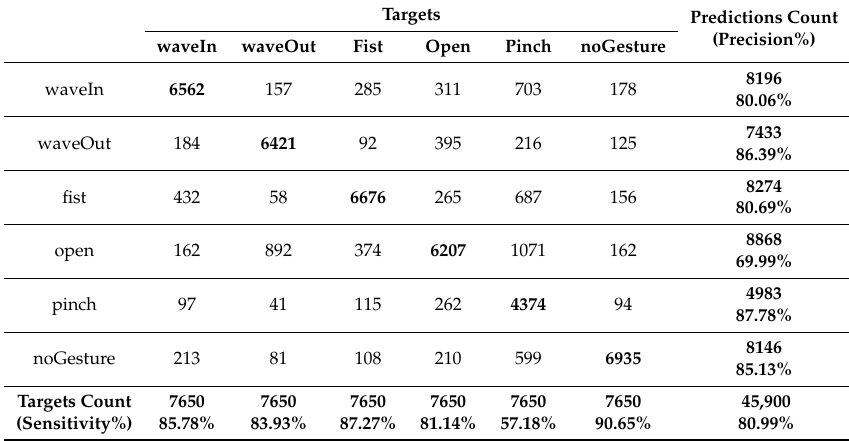
Table A12. Confusion matrix for experiment 4 . Synchronization gestures ( sync = 3 )